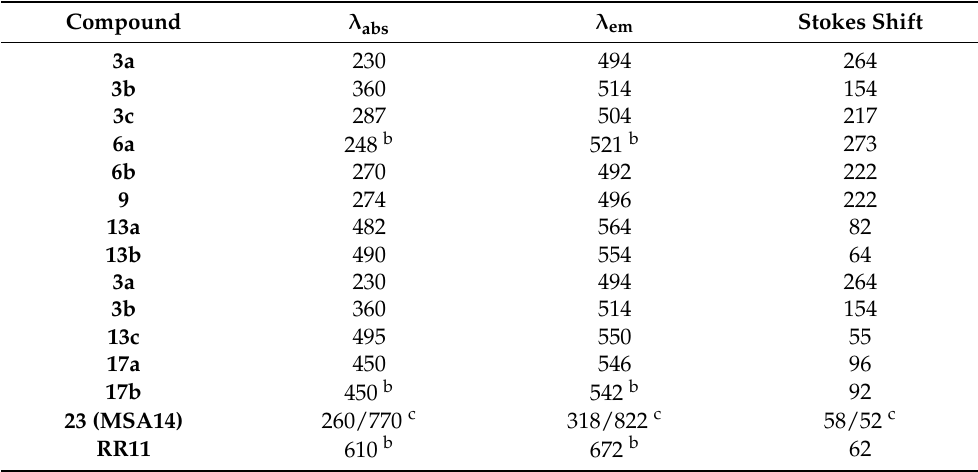
The λ abs and λ em , of the target compounds were measured in aqueous solution Table 1. Fluorescence properties of the new compounds a .